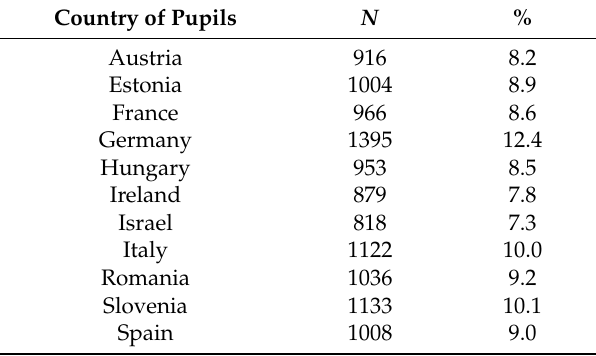
Table 1. Sample characteristics regarding country of